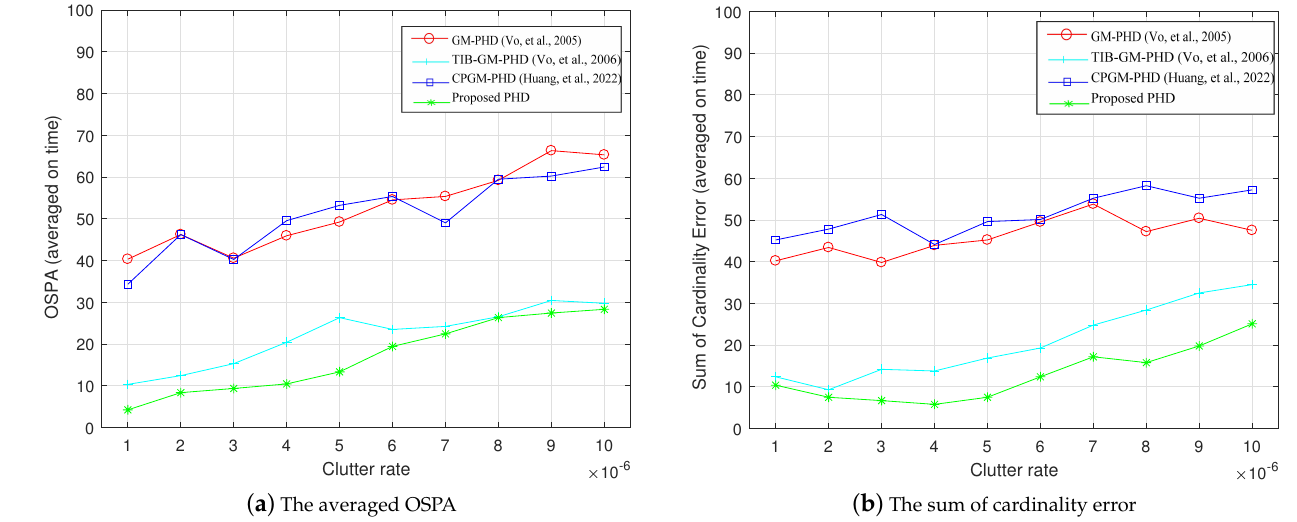
Figure 8. The averaged OSPA and the sum of cardinality error of GM-PHD, TIB-GM-PHD, CPGM- PHD and Proposed PHD with different clutter rate (The numbers in brackets represent references to various PHD methods).